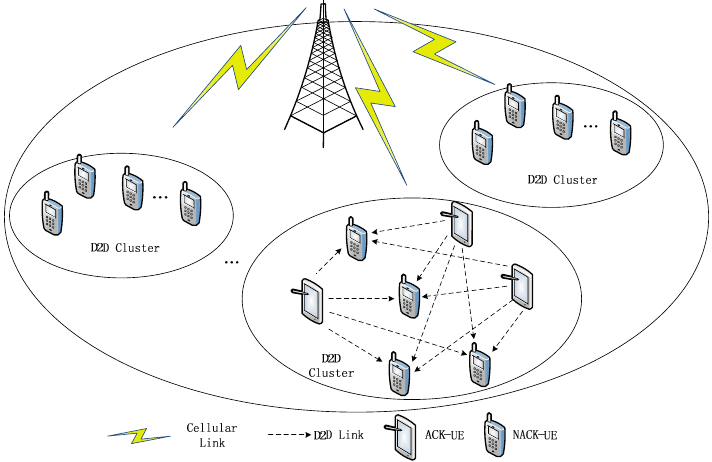
Figure 1. D2D clusters with ACK-UEs and NACK-UEs in the cellular